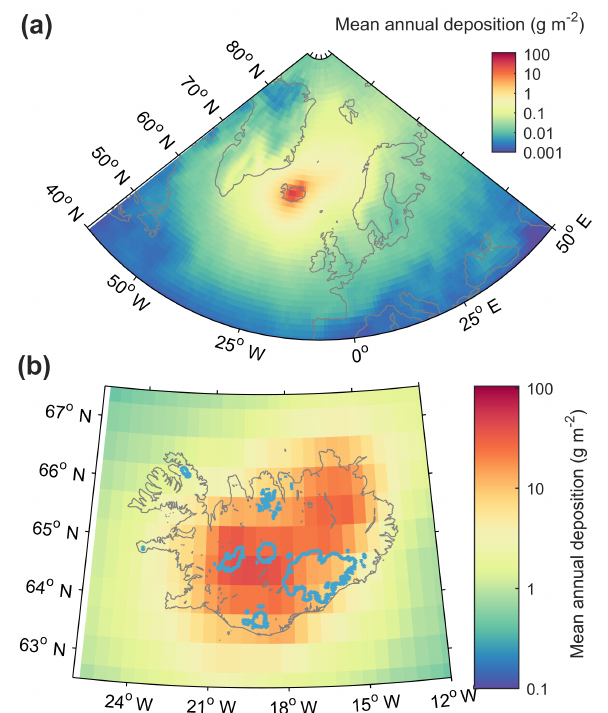
Figure 10. Mean annual dust deposition (gm − 2 ) simulated with FLEXPART in years 1990–2016 for the North Atlantic region (a) and Iceland (b) . Maximum values are lower in the upper panel than in the lower panel as this figure shows averages over larger areas. The blue lines in the bottom figure are glacier